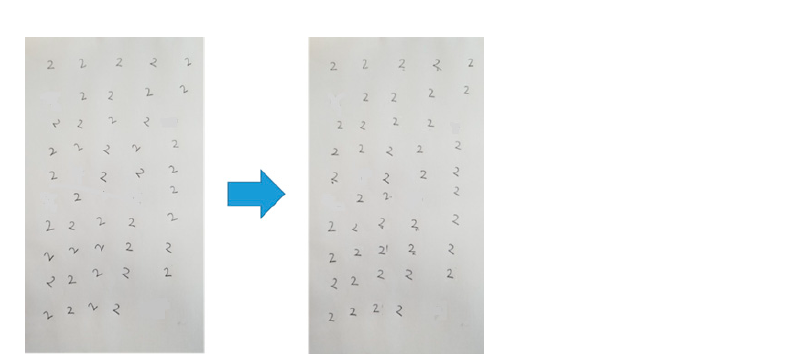
Figure 15. Tilt correction examples of “2” following the proposal ( left : original, right : tilt correction results).